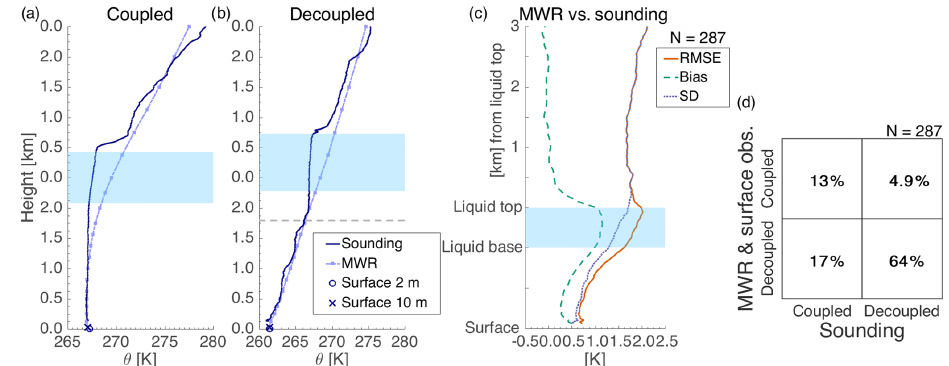
Figure 3. Examples of θ -profiles from sounding and MWR, as well as surface observations: a coupled cloud on 24 October 2017 11:55– 12:05UTC (a) and a decoupled cloud on 1 February 2018 16:47–16:56UTC (b) . The blue shaded area indicates the cloud layer, where cloud base and top are determined as the median values of the Cloudnet-based cloud base and top for the duration of the sounding. The gray dashed line indicates the decoupling height defined from the sounding θ -profile. Comparison of potential temperature profiles from sounding and retrieved from MWR measurements when P-MPCs were present, with height normalized with respect to the liquid layer (c) . Comparison of the diagnosed coupling with the new method based on MWR and surface observations and based on sounding profiles (d)